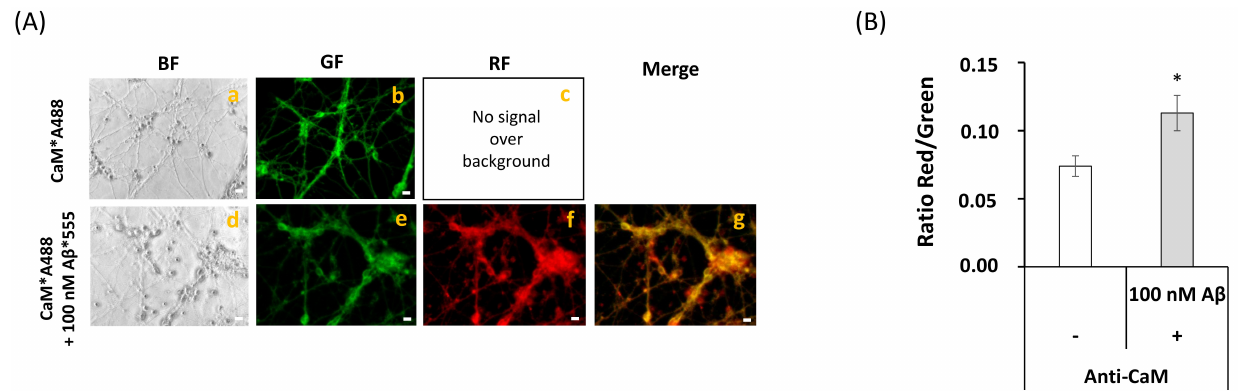
Figure 3. Extensive FRET between anti-CaM antibody stained with a secondary Alexa488 fluorescent antibody and A β (1–42)-HiLyte TM -Fluor 555 in fixed and permeabilized mature CGN . ( A ) Representative quantitative fluorescence microscopy images of CGN stained with anti-CaM antibody (1716-1)/ IgG-Alexa488 (CaM*A488, a–c) or with anti-CaM/IgG- Alexa488 and A β (1–42) HiLyte TM -Fluor 555 (CaM*A488/ A β (1–42), d–g). Bright-field (BF), green fluorescence (GF), and red fluorescence (RF) images are shown for each one of the selected fields, and the orange-yellow areas (Merge image) point out the higher intensity FRET regions (g). The exposure time for GF and RF images was 0.03 s. Scale bar inserted in fluorescence microscopy images = 10 µ m. (B) Ratio of red/green fluorescence intensity per pixel (RF/GF) obtained from the analysis of the fluorescence intensity data of CGN somas stained with anti-CaM*IgG-Alexa488 only (CaM*A488) and double stained with anti-CaM*IgG-Alexa488/A β (1–42) HiLyte TM -Fluor 555 (CaM*A488/A β (1–42)). The results shown in ( B ) are the mean ± s.e. (*) p < 0.05 (i.e., statistically significant with respect to the control (CGN labeled with the Alexa488 FRET donor